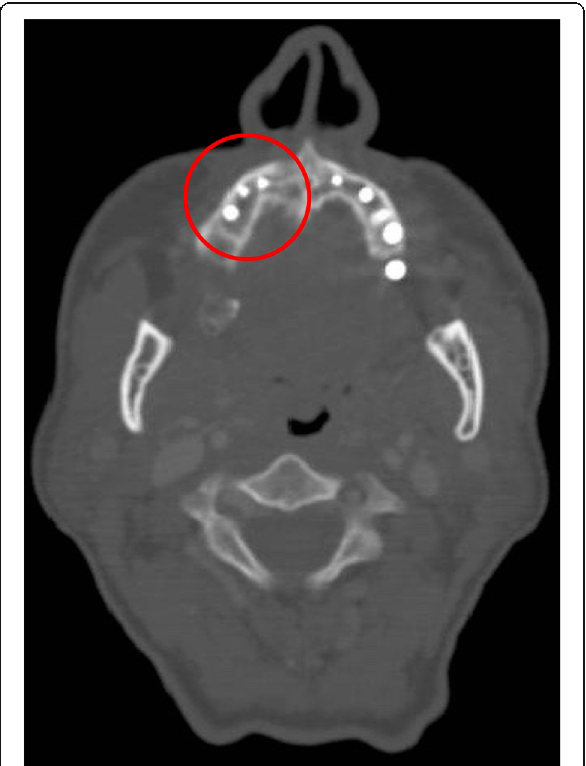
Fig. 13 Pt no. 3. Preoperative CT